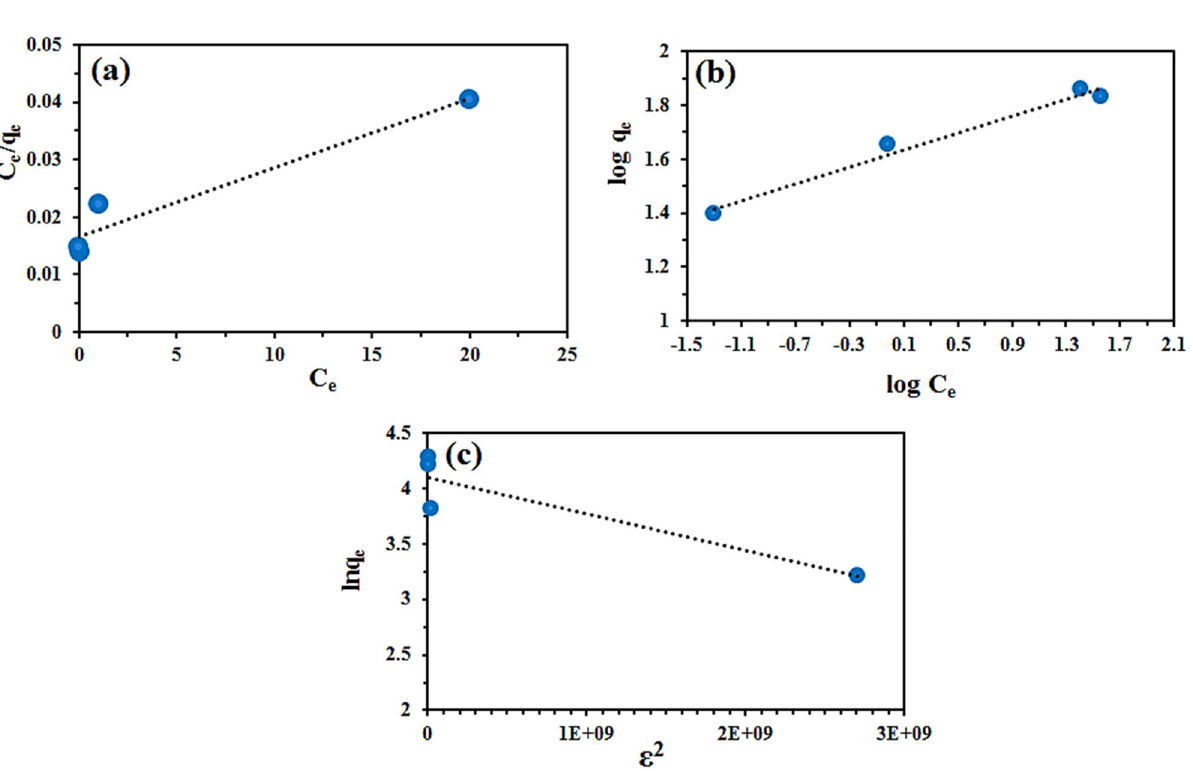
Figure 14. The linear plots of Langmuir ( a ), Freundlich ( b ), and DR ( c ) for the removal of RO16 by lignocellulosic